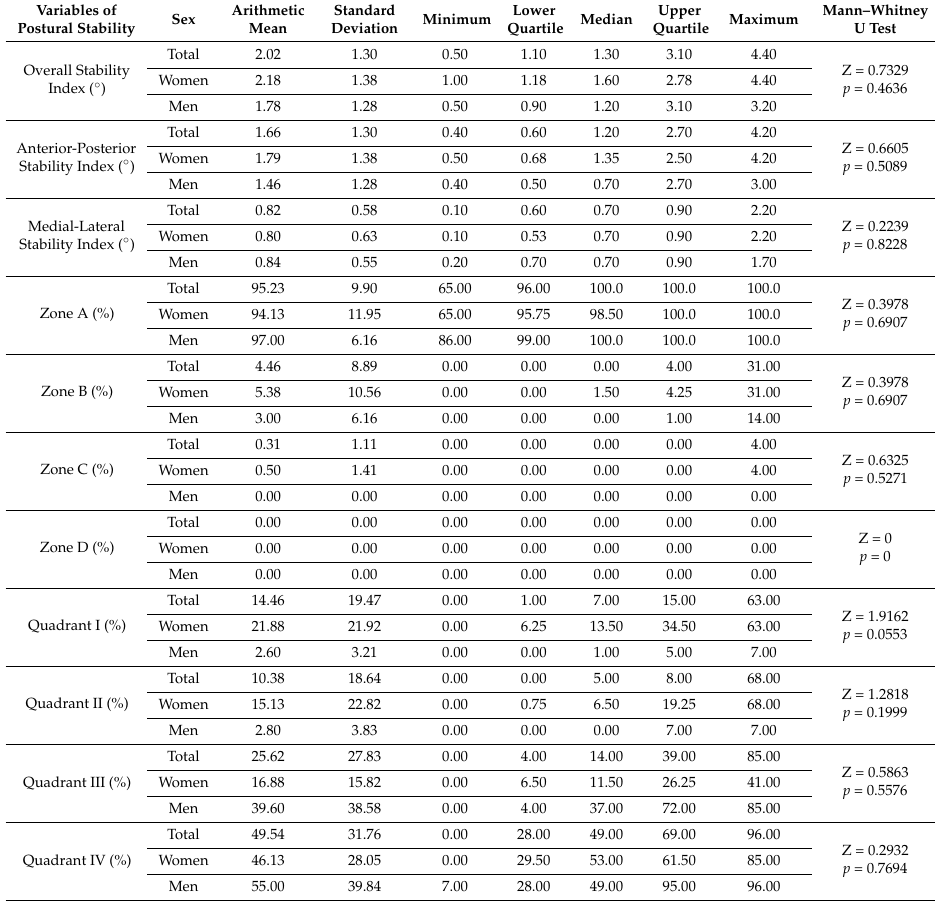
Table 3. Sex and postural stability after L-dopa administration.